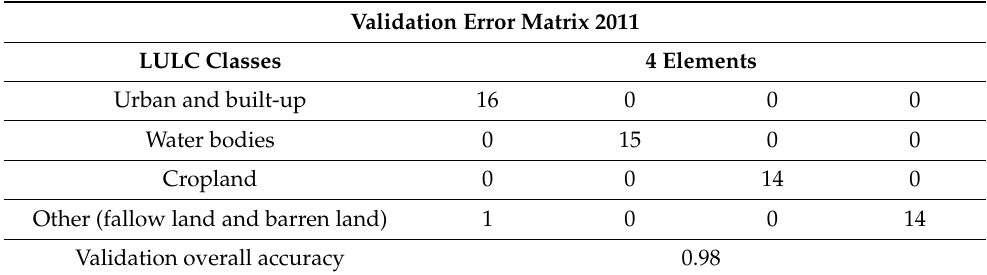
Table 1. Evaluation of the accuracy assessment of the LULC classification for the year